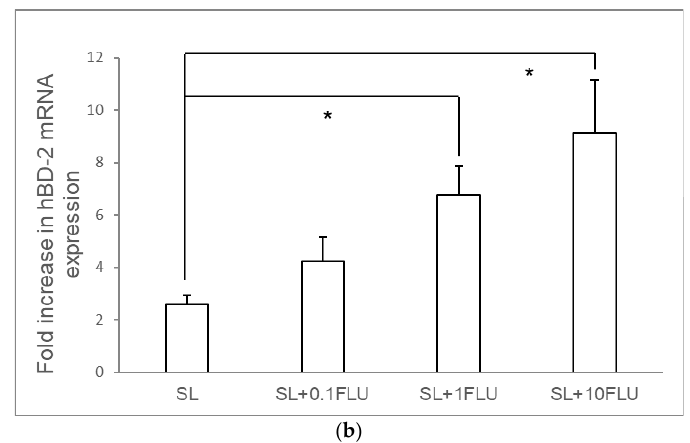
Figure 7. The effect of fluvastatin on IL-8 and hBD-2 mRNA expression levels in Salmonella -infected Caco-2 cells. Cultured Caco-2 cells were either uninfected or infected for 1 hour with S. Typhimurium wild-type strain SL1344 (SL) in the presence or absence of different concentrations of fluvastatin (FLU)(0.1, 1, 10 μM) for 24 h. Total RNA was prepared after infection and analyzed by real-time quantitative PCR to estimate amounts of IL-8 ( a ) and hBD-2 ( b ) transcript. The amount of IL-8 and hBD-2 mRNA produced, normalized to the corresponding amount of GAPDH transcript, is shown as the fold increase over uninfected, control (CON) cells. The results indicate the means and standard deviations for duplicate wells from at least three separate experiments (* p < 0.05 compared to Salmonella infection only).